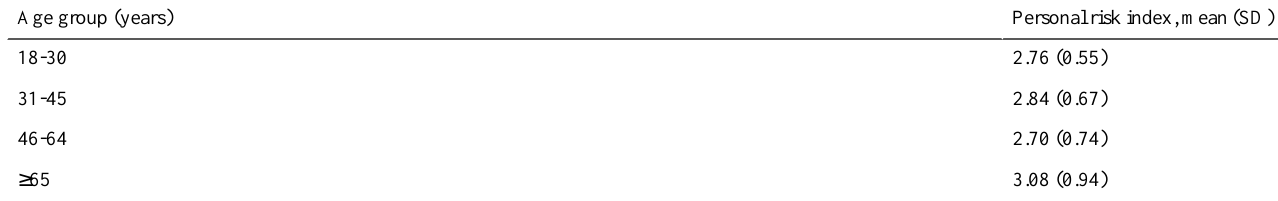
Table 2. Comparison of the personal risk perceptions between age groups using an ANOVA model